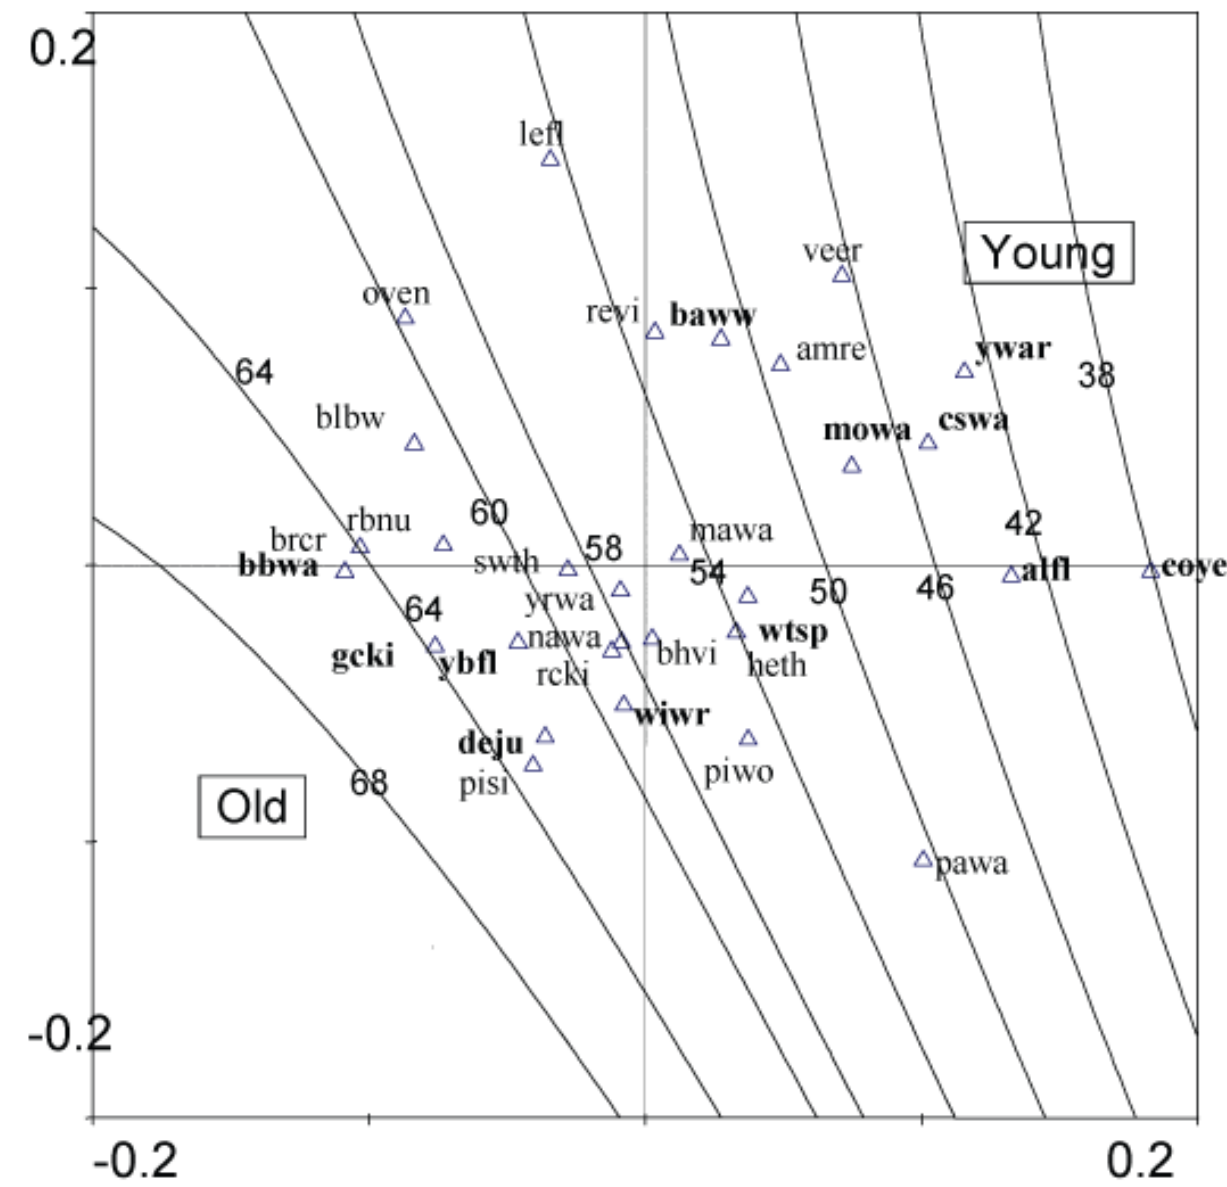
Fig. 6. Species ordination (CCA), with overlay of isopleths (GLM) for stand age (AGE) in years. Species with a significant effect (ANOVA p < 0.05) are highlighted in bold. Isopleths delineate species predicted to occur in areas of young to old